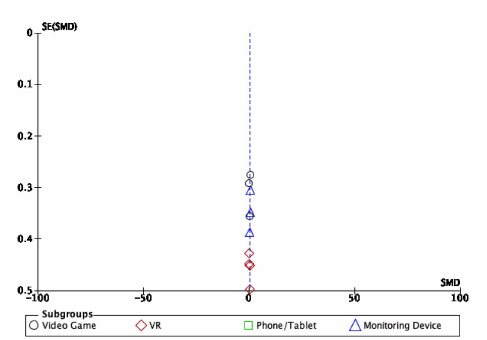
Figure 5. Funnel plot of the standardised mean difference against the standard error for physical activity.